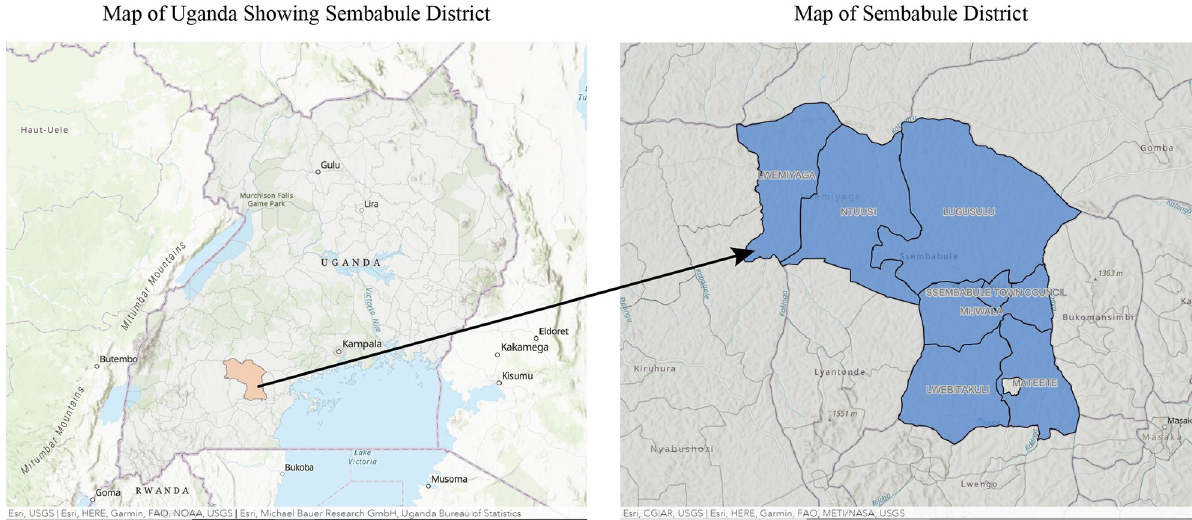
Fig 1. A map of Uganda and Sembabule district. Esri, USGS | Esri, HERE, Garmin, FAO, NOAA, USGS | Esri, Michael Bauer Research GmbH, Uganda Bureau of Statistics.